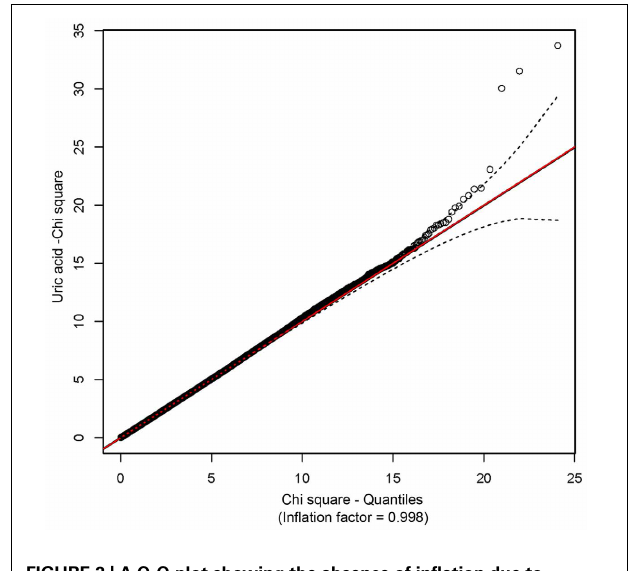
FIGURE 2 | A Q-Q plot showing the absence of inflation due to population stratification.